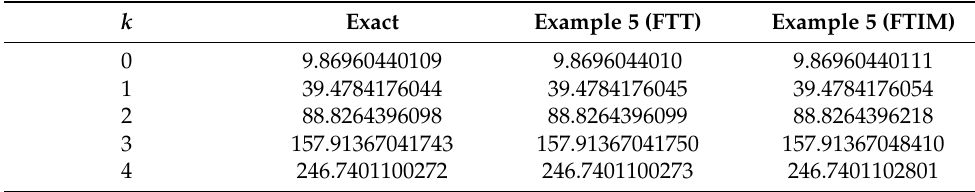
Table 5. Comparing the eigenvalues for Example 5 with the present BSFM using B 0 = 1 to the exact ones.